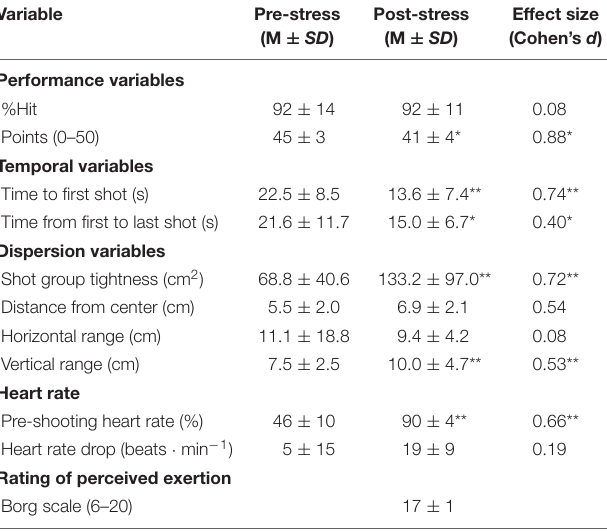
TABLE 3 | Mean ± standard deviation values for shooting performance, dispersion, temporal variables, rating of perceived exertion and heart rates for the three pre-physical stress tests and two post-physical stress